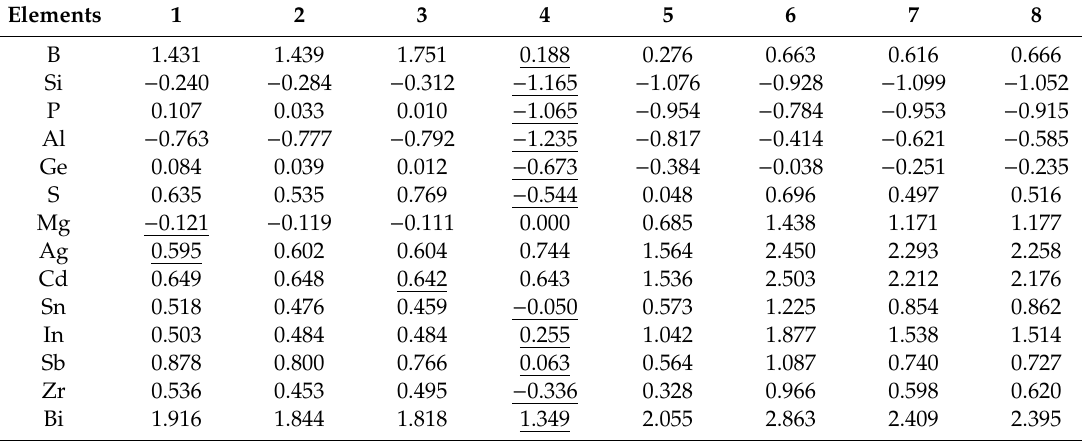
Table 4. Substitutional energies (eV) of alloy atoms at di ff erent positions. Figure 1 lists the 1–8 representing the di ff erent substitutional sites. Underline indicates the smallest substitutional energy.